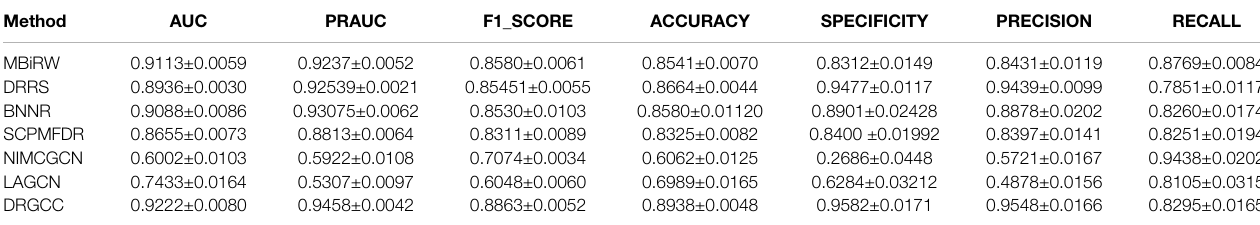
TABLE 4 | Performance of comparison methods on HDVD dataset.